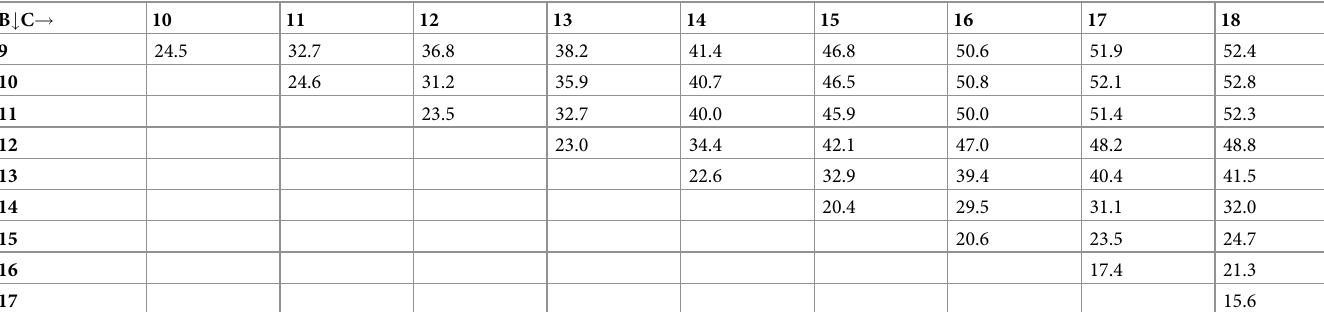
Table 4. 95% confidence interval (in mm) for forecasting the height at the age C for girls using the values from the age of 8 to the age